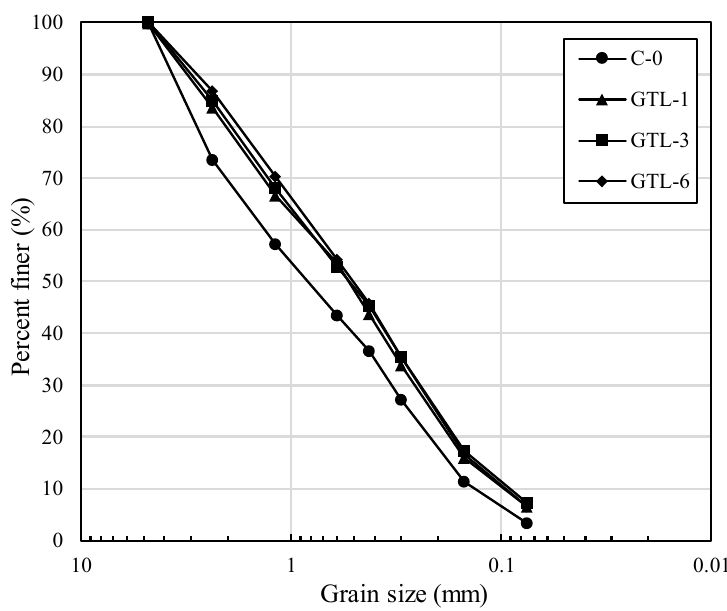
Figure 1. Particle size distribution curves of soil before and after thermal treatment. Note: C: original soil; G: soil with gasoline pollutant; T: the concentration of pollutant is 10,000 ppm; L: heating temperature is 320 °C; 1: heating for 10 min; 3: heating for 30 min; 6: heating for 60 min.